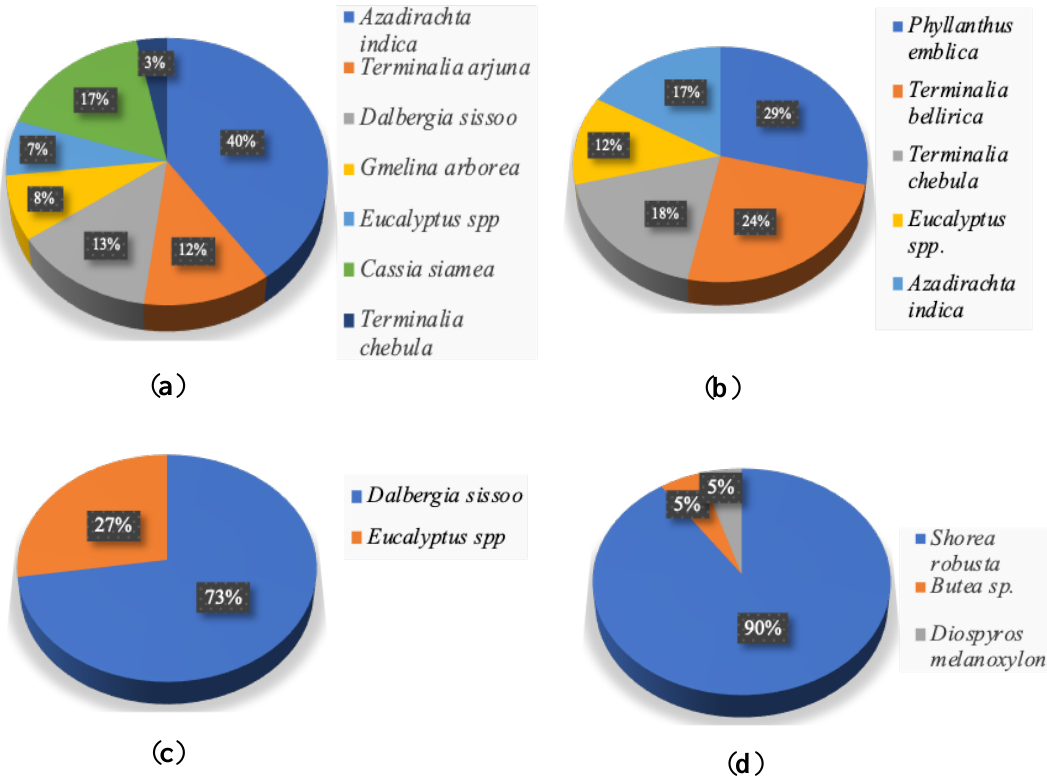
Figure 3. Tree species growing in the reclaimed mine soil chronosequence sites along with relative density: ( a ) 25-year-, ( b ) 10-year-, ( c ) 5-year-old afforested dump and ( d ) reference forest. Table 1. Vegetation characteristics and accumulation of biomass carbon in afforested chronosequence dumps and reference forest (mean ± SE, n = 5).